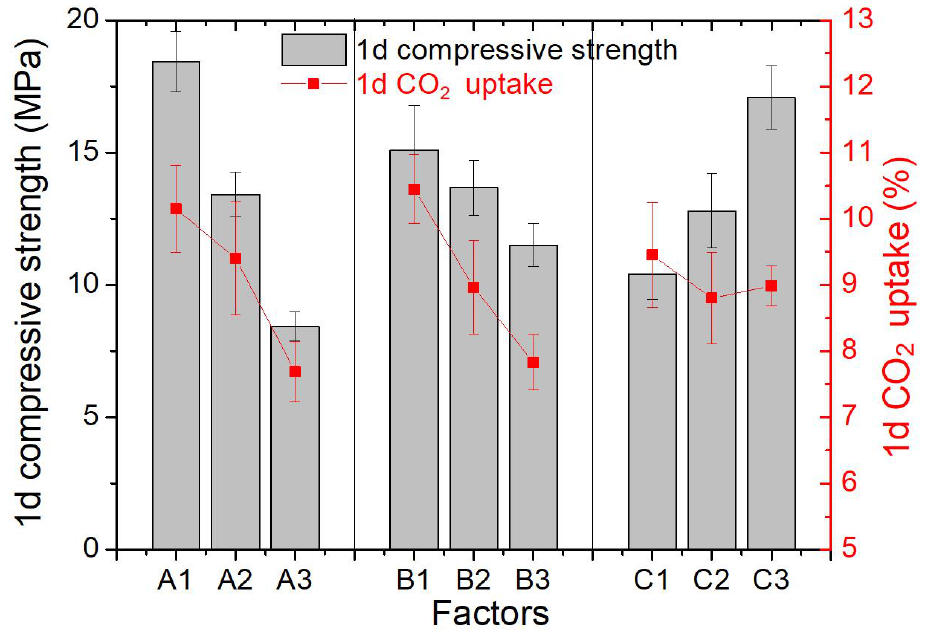
Figure 4. The effect curve of three factors on 1 d compressive strength and 1 d CO 2 uptake capacity.